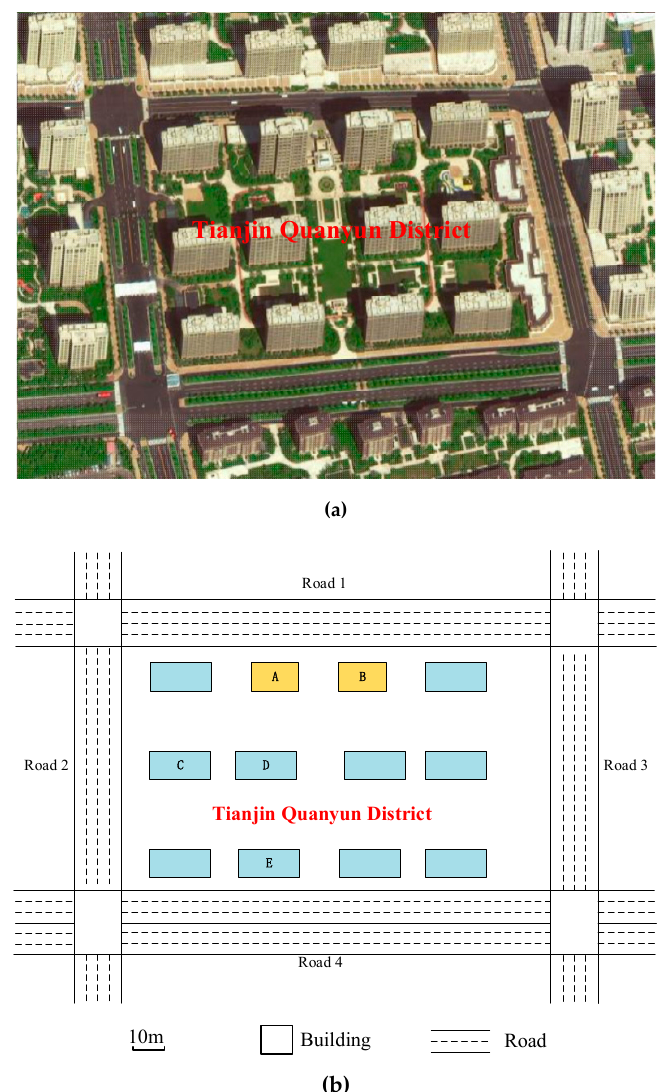
Figure 9. Configuration of study case. ( a ) Map of Tianjin Quanyun District; ( b ) road network and building information.